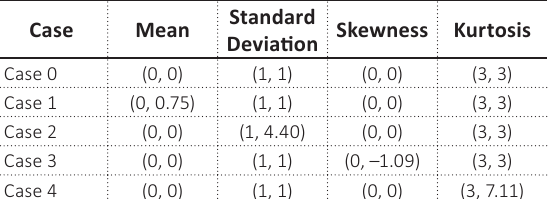
Table 1. Simulation study